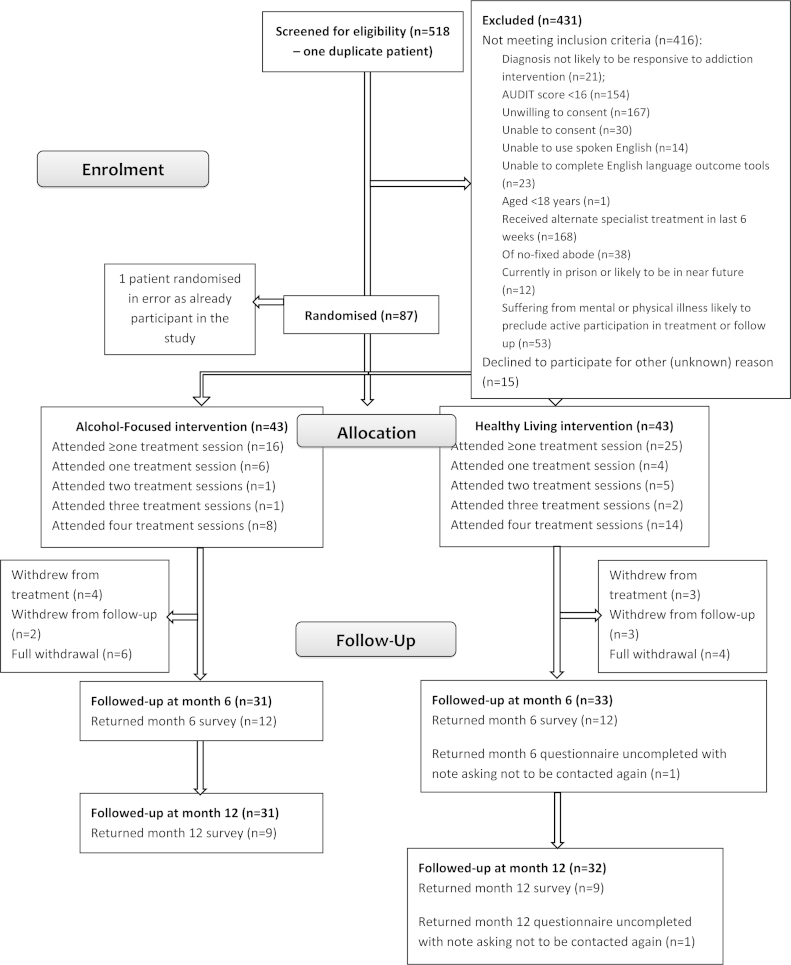
CONSORT diagram.